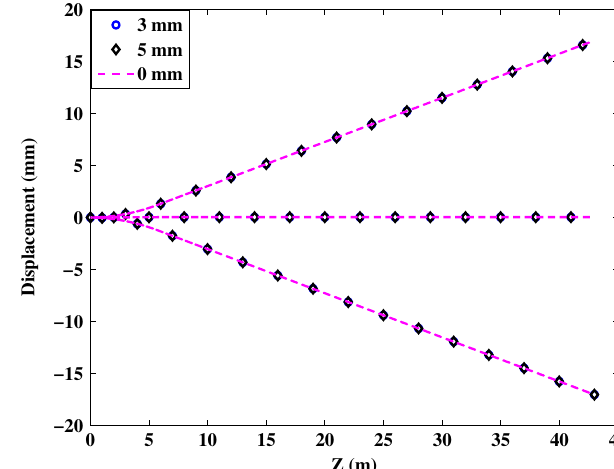
FIG. 16. Vertical deflection of an 11 GeV electron due to eight 2-cell cavities for three different rf phases (cid:4) A;B;C and V def ¼ 673 : 2 kV .